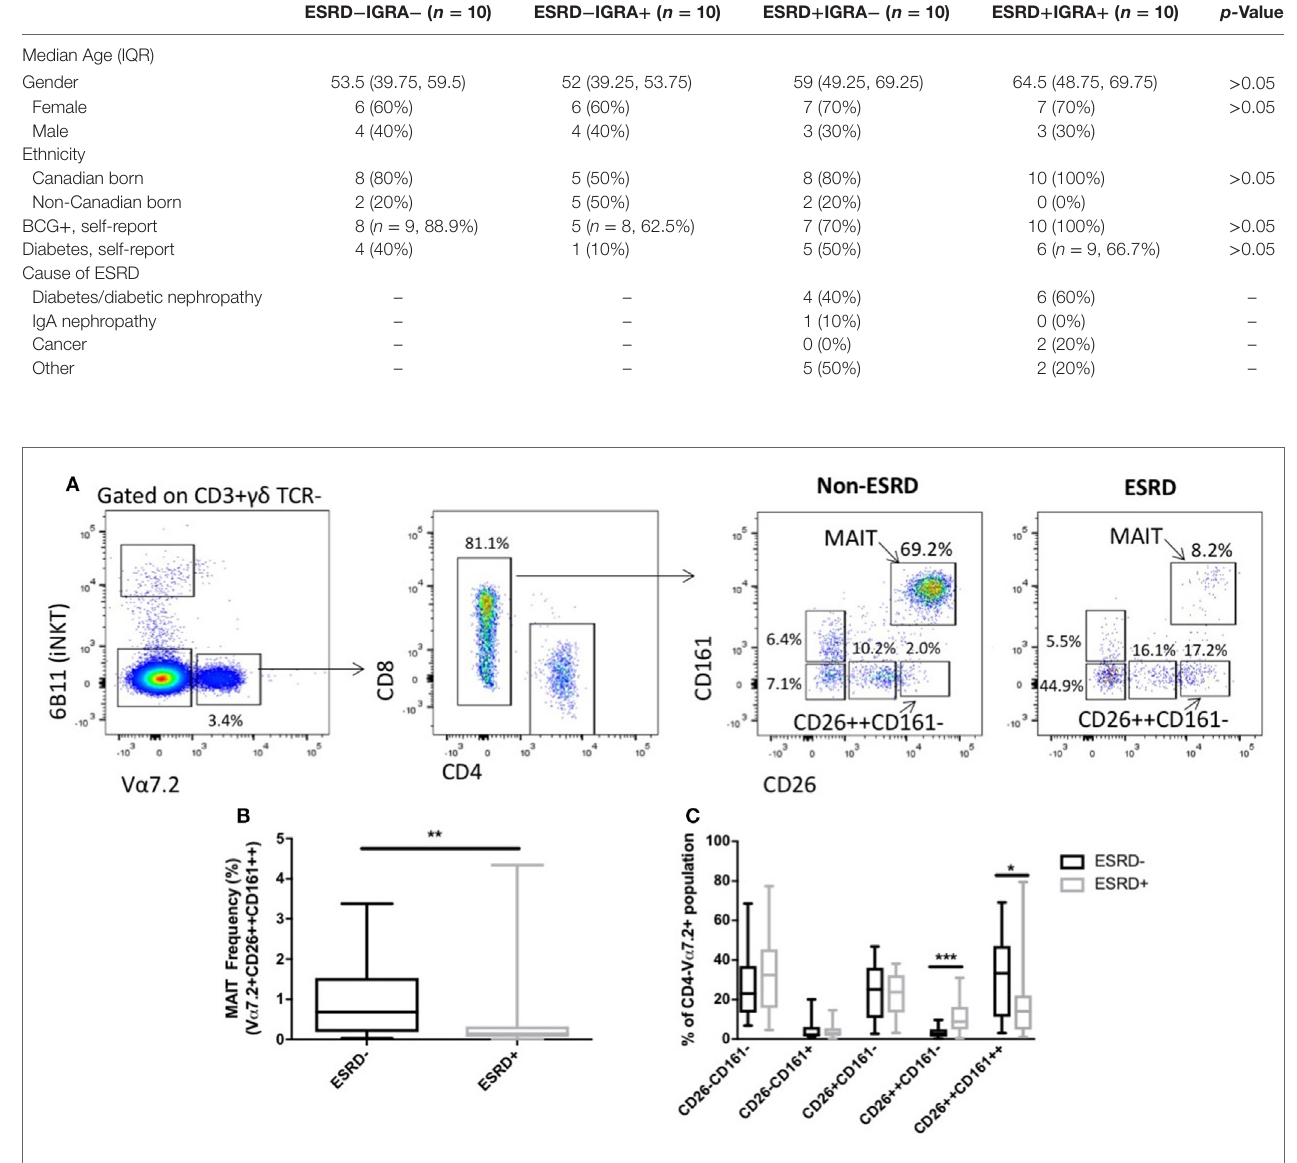
FigUre 1 | Identification of mucosal-associated invariant T (MAIT) cells using V α 7.2, CD161 and CD26 ( n = 20 per group). (a) Representative staining of MAIT cell gating strategy. CD3 + γδ TCR − 6B11 − cells were gated for V α 7.2 expression. CD4 − CD161 ++ CD26 ++ cells were identified as MAIT cells. Other V α 7.2 + CD4 − populations were gated based on expression of CD161 and CD26. (B) Comparison of MAIT cell frequency (as a proportion of CD3 +γδ TCR − cells) between non-end-stage renal disease (ESRD) and ESRD groups. (c) Comparison of the frequency of CD26 and CD161-expressing populations within the V α 7.2 + CD4 − gate. Comparisons performed by Mann–Whitney test, ** p < 0.01, *** p < 0.001.